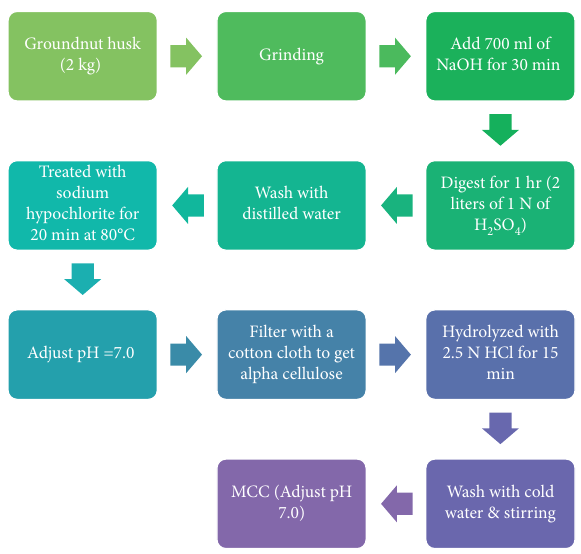
Figure 2: Flow diagram for extraction of MCC from groundnut.